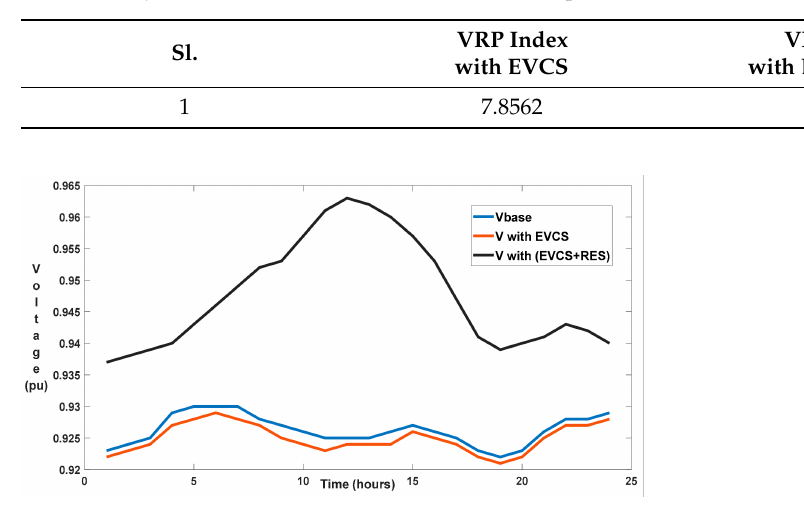
Table 10. Objective function value for 24 h variation of power.